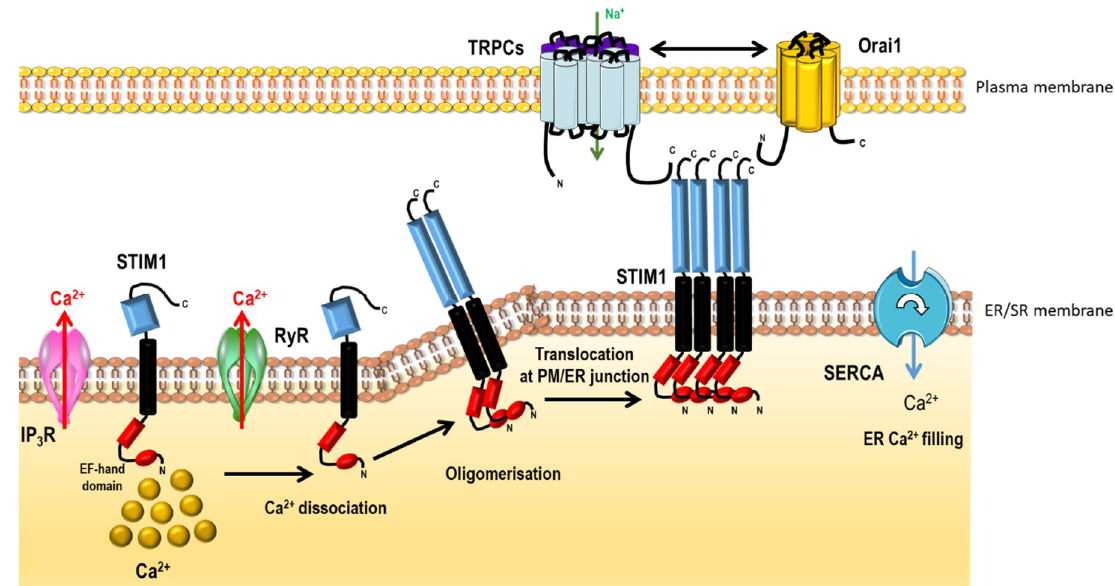
Figure 8. Activation mechanism of store-operated Ca 2+ channels. The reduction in intra-luminal Ca 2+ concentration triggers STIM1 aggregation and their interaction with Orai1 and/or TRPCs, enabling Ca 2+ (TRPC/Orai) or cationic (TRPC) entry. TRPCs, Transient receptor potential-canonical; IP3R, inositol 1,4,5-trisphosphate receptor; RyR, Ryanodine Receptors; ER, Endoplasmic reticulum; STIM1, stromal interaction molecule; SERCA, Sarcoplasmic/endoplasmic reticulum Ca 2+ ATPase.